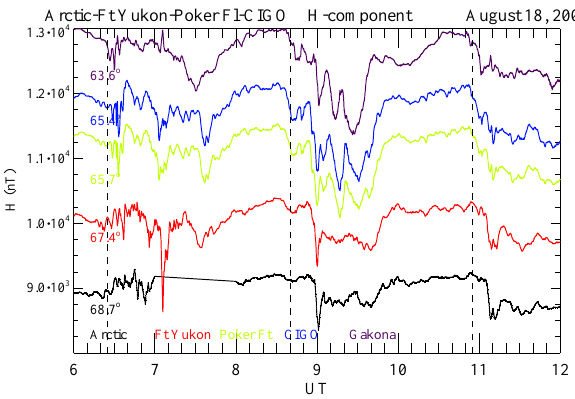
Figure 8. Alaska meridional chain magnetometer data ( H -component deflections) from stations Gakona (violet, 63.6 ◦ MLAT), CIGO (blue, 65.4 ◦ MLAT), Poker Flat (green, 65.7 ◦ MLAT), Fort Yukon (red, 67.4 ◦ MLAT), and Arctic Village (black, 68.7 ◦ MLAT). Pseudo-breakups of the WEJ at 06:25, 08:40, and 10:55UT are marked by vertical guidelines. Major onsets are identified at 07:02, ∼ 09:00, and 11:00UT.